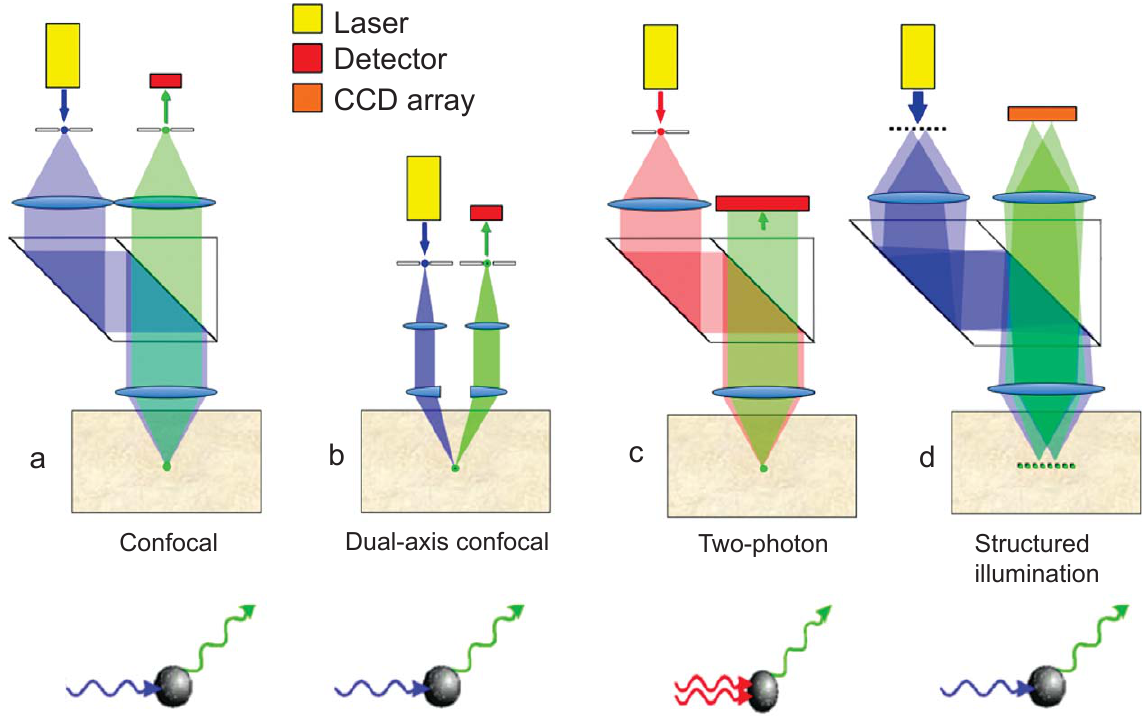
Fig. 5. a: The conventional confocal microscope, using a high-NA (0.8–1.4) objective and two pinholes to provide a point source and point detector. Images are collected by scanning the focal spot within the specimen in either reflectance or fluorescence (shown) modes. Excitation light (blue) is absorbed by the fluorescent molecules in the specimen, and fluorescence emission (green) is collected by the point detector. b: The dual-axis confocal microscope, using two low-NA (0.1–0.2) objective lenses and two pinholes to provide a point source and point detector. The excitation (blue) and emission (green) beams are spatially separated within the specimen, except where they overlap at the focus. c: The multiphoton microscope using a high-NA (0.8–1.4) objective and a single pinhole to provide a point source. The red beam represents the long-wavelength excitation light (high-peak-power pulsed laser), which is non-linearly absorbed by the fluorescent molecules in the specimen. The efficiency of two-photon absorption, for example, scales as the square of the intensity of the light, and is therefore confined to just the focus of the excitation beam. The green beam represents the shorter-wavelength fluorescence emission light collected by a large area detector. d: The structured illumination microscope can be used to gather full-field (single-shot) 2D images by a photodetector array (CCD) in either reflectance or fluorescence (shown) modes. The images are quasi-optically-sectioned due to the fact that the structured pattern is only imaged with high contrast at the focal plane within the specimen. By spatially modulating the illumination pattern, out-of-focus (low-contrast) light may be distinguished from, and digitally filtered away from the in-focus light that is modulated with high contrast. The multiple blue beams represent a pattern of excitation light beams emanating from a structured light source, which is absorbed by the fluorescent molecules in the specimen. The respective green beams represent the fluorescence emission light collected by the